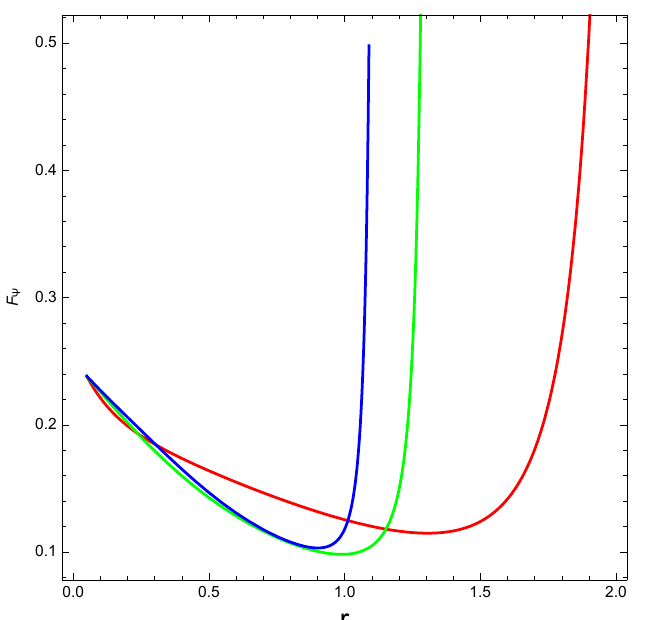
Figure 8. Solution of F ( R ( r )) for R adopted as a quadratic function of radius. The evolution of the partial derivative of f ( R ) is obtained by Equations (8) and (33). We have fixed the values of a 0 , a 1 , a 2 , K , and C 1 . The red, green, and blue lines correspond to small perturbations of λ 0 , Ψ 0 , η 1 , η 2 , and η 3 , respectively. The graphical representation of the scalar potential is shown by comparing Equation (7) and Equation (32). For three different expressions of the Ricci scalar ( R ), the solutions set of f provides different forms. Comparing Equation (7) with Equation (35), Equation (37), and Equation (39), we obtain the plot for different values of λ 0 , Ψ 0 , η 1 , η 2 , η 3 , a 0 , a 1 , a 2 , K , and C 1 in Figure